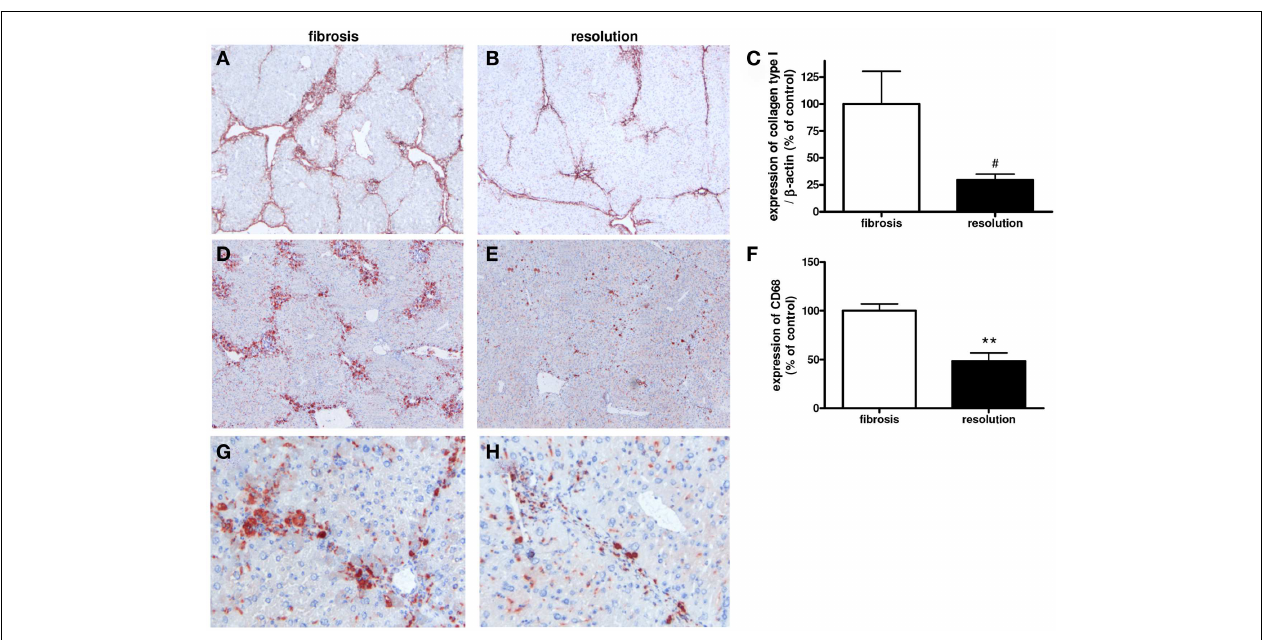
undergoing resolution [after cessation of CCl4 administration, resolution (B,E,H)] . ** p < 0.01, # p < 0.1. Magnifications: 40 × (A–E) and 200 × (G,H) . N = 6/group.